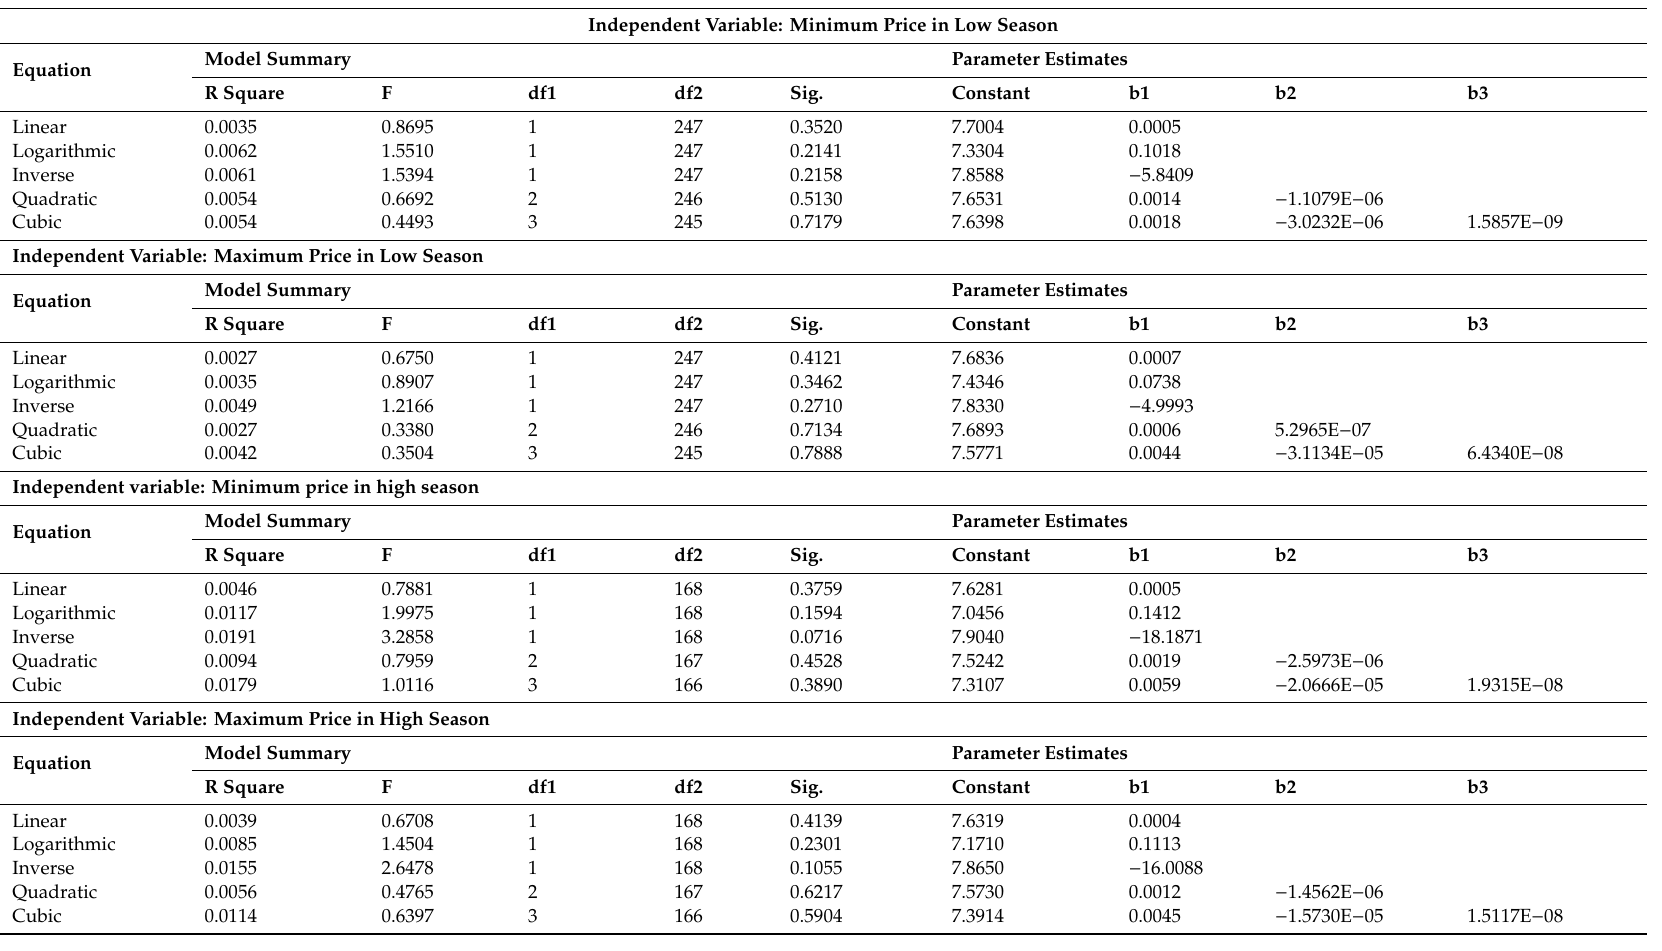
Table 5. Model summary and parameter estimates of regression analysis in Gran Canaria destination with value as dependent